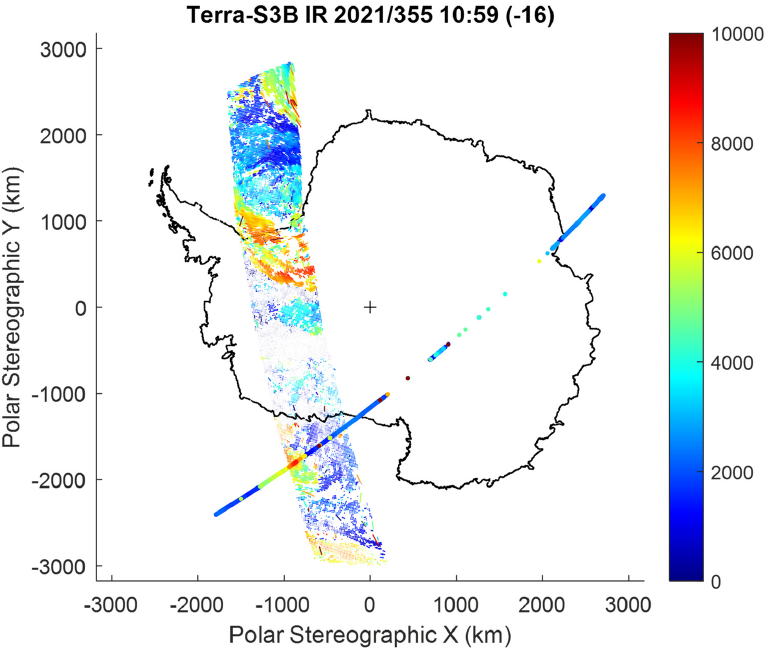
Figure 6. A swath of stereo winds over the South Pole for South Polar summer (21 December 2021, LWIR) with an intersecting line of LiDAR top-layer cloud-top heights. Wind vectors indicate speed and direction. A heatmap codes the retrieved wind height. The time difference of Sentinel-3 relative to Terra, Δ t , is noted in minutes in parentheses in the title. The horizontal and vertical axes are km in a polar stereographic projection.